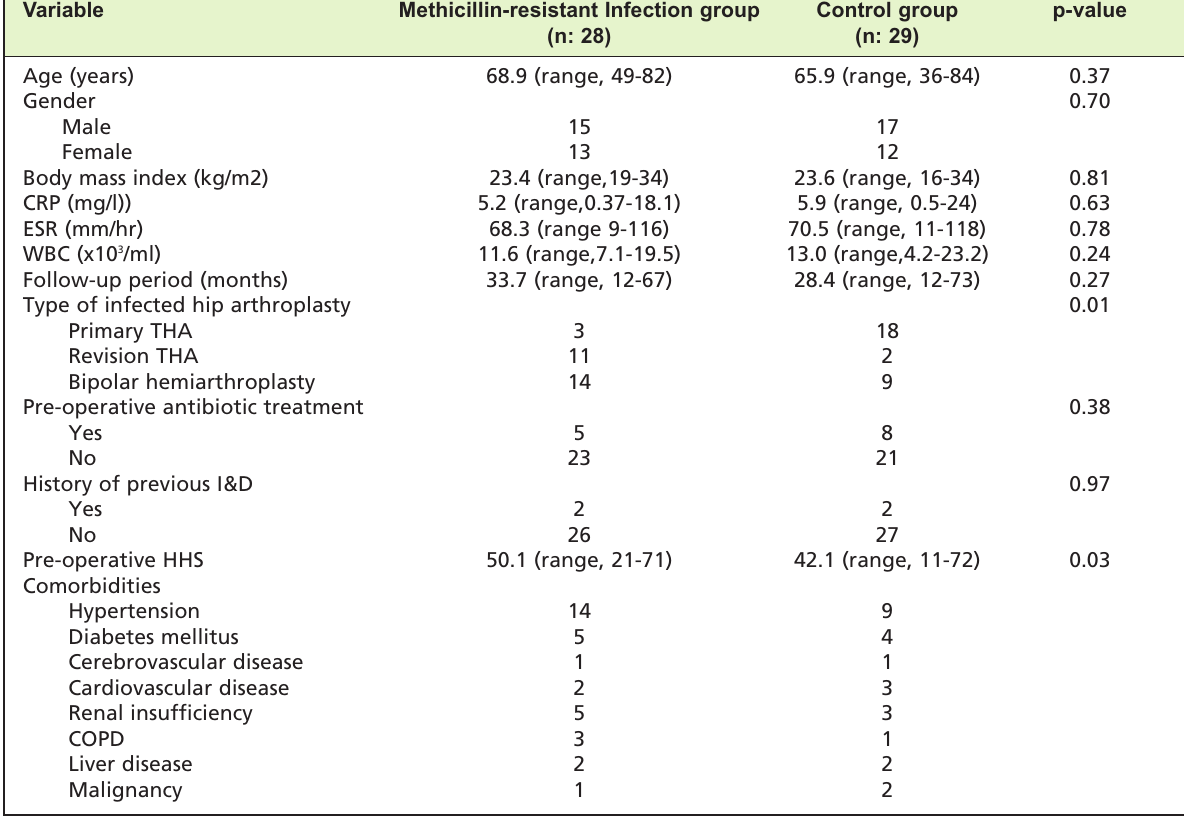
Baseline data of Methicillin-resistant group versus control group Table I: CRP: C-reactive protein, ESR: erythrocyte sedimentation rate; WBC: white blood count; THA: total hip arthroplasty; I&D: irrigation and debridement; COPD: chronic obstructuve pulmonary disease; HHS: Harris hip score.